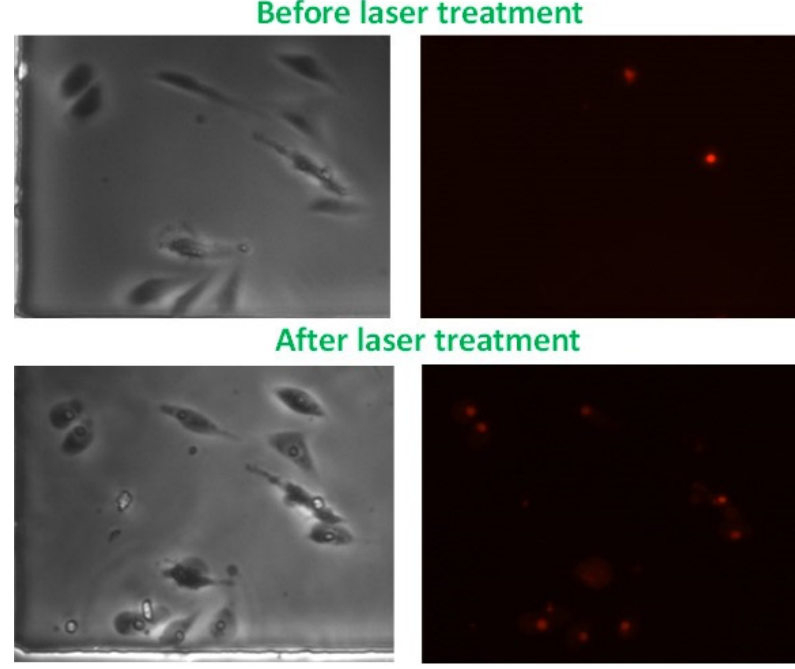
Figure A1. Images from Figure 4 in separate bright field and fluorescent photos.